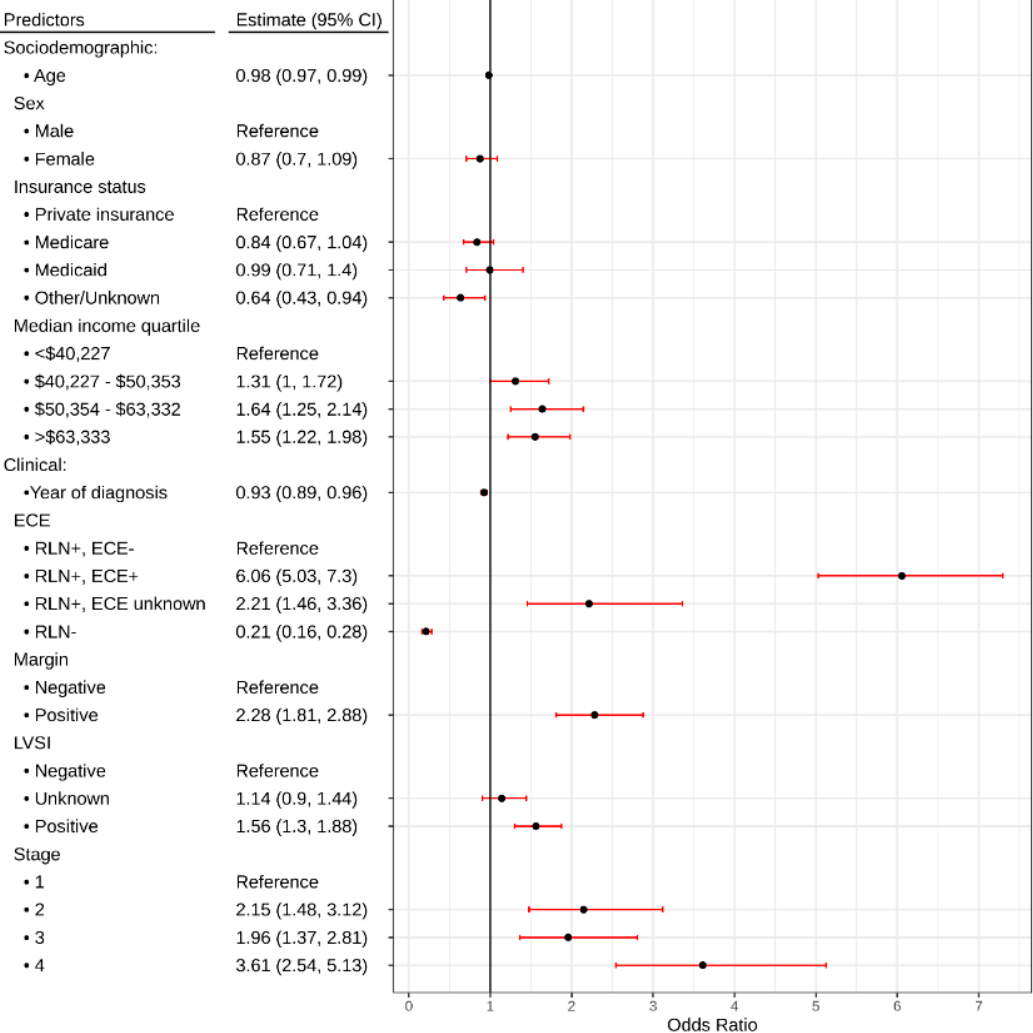
Figure 5. Forrest plot depicting odds ratios for receipt of adjuvant therapy in TORS-treated patients. RLN: Regional lymph node; ECE: Extracapsular extension; LVSI: Lymphovascular space invasion.